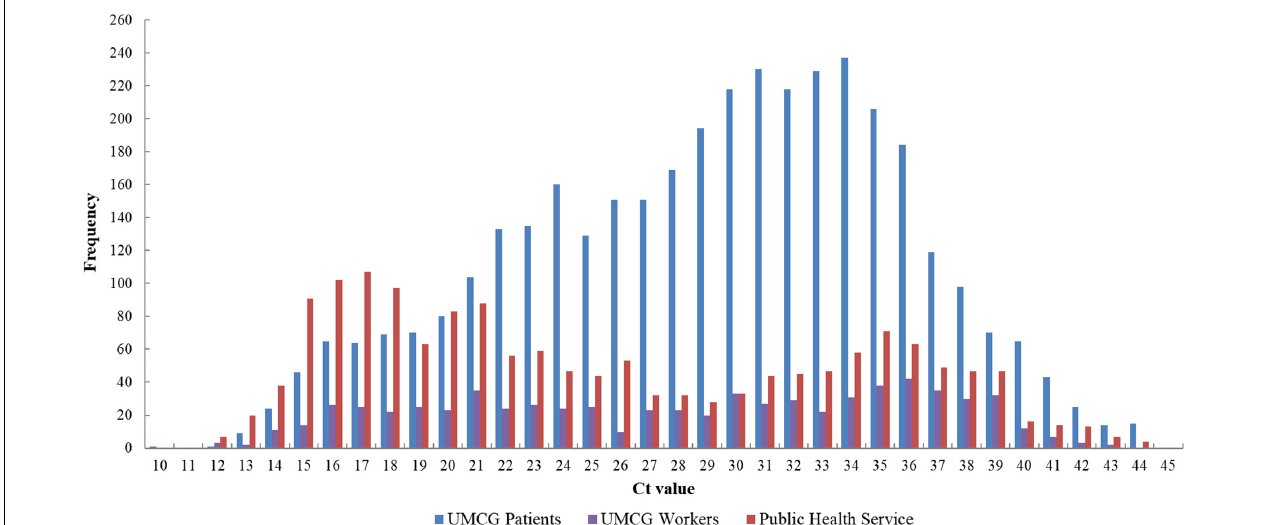
FIGURE 1 | Distribution of Ct values of SARS-CoV-2 positive patients from January 2020 to May 2021 ( n = 6,035). RT-qPCR was performed by targeting the E gene of SARS-CoV-2. UMCG patient Ct values also contain follow-up samples (in-patients and out-patients). The Ct values plotted included both symptomatic and non-symptomatic detections. UMCG, University Medical Center Groningen; Ct, cycle threshold.